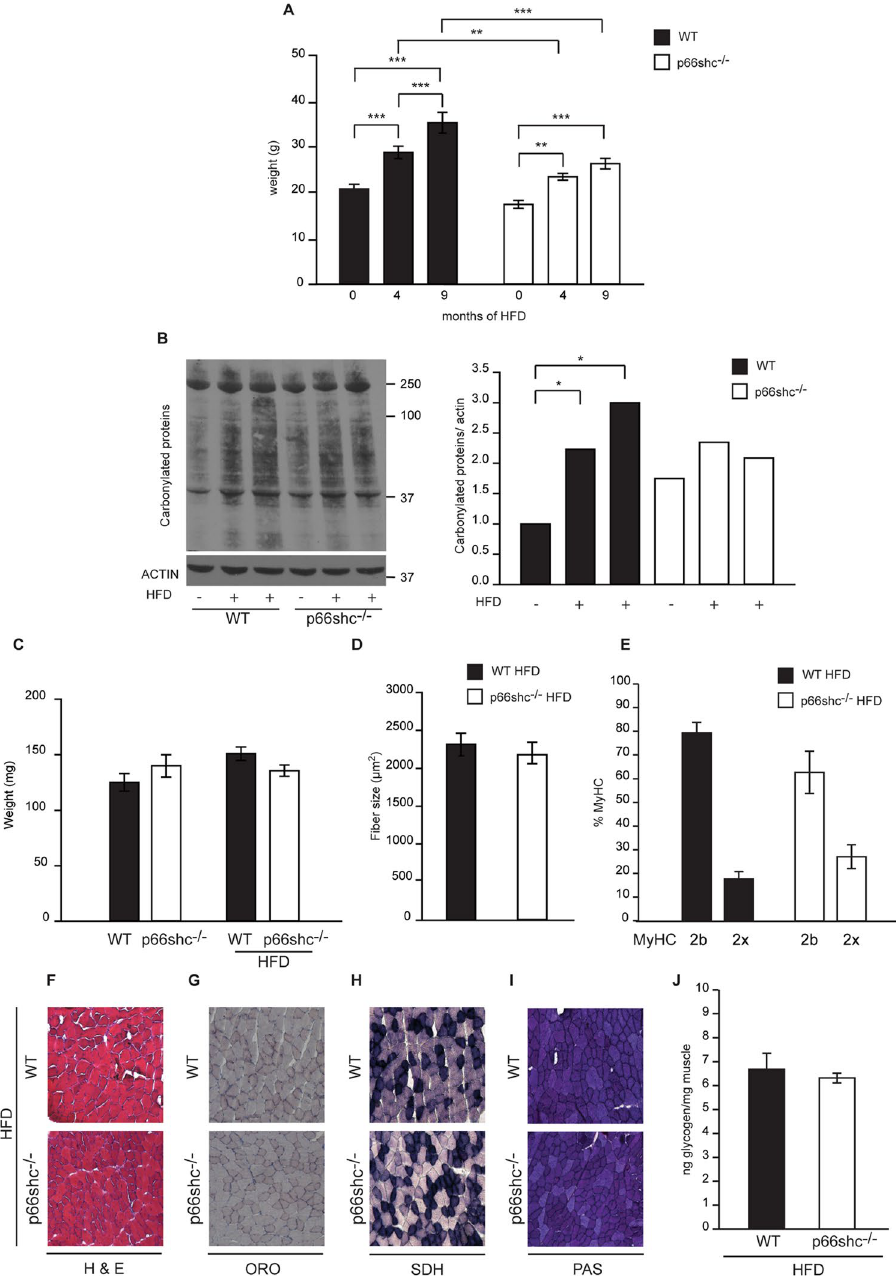
Figure 4. Trophic and metabolic properties of p66shc − / − muscles upon HFD. ( A ) Female wt and p66shc − / − mice were fed with HFD for 4 and 9 months and body weights were plotted. ** p < 0.01, *** p < 0.005, pairwise multiple comparison (Holm-Sidak method) of 7 animals per condition. Data are presented as mean ± SEM. ( B ) Western blot analysis of carbonylated proteins of wt and p66shc − / − muscles mice after HFD (9 mo) and quantification by densitometry. * p < 0.05 pairwise multiple comparison (Holm-Sidak method). Cropped blots are displayed, and full-length blots are presented in Supplementary Figure S1. ( C ) Gastrocnemius muscle weights of wt and p66shc − / − mice in chow and in HFD conditions. Data are presented as mean ± SEM (5 animals per group). ( D ) Mean fiber size of TA muscles of wt and p66shc − / − mice after HFD (9 mo). Data are presented as mean ± SEM (3 animals per group).( E ) Quantitative myosin distribution analysis of wt and p66shc − / − muscles mice after HFD (9 mo). Data are presented as mean ± SEM (5 animals per group). ( F ) H&E staining of transversal cryosections of TA muscles after HFD (9 mo). ( G – J ) Analysis of the metabolic properties of wt or p66shc − / − muscles after HFD (9 mo). ( G ) Lipid accumulation detected by Oil-red-O (ORO) staining. ( H ) SDH activity assay. ( I ) Glycogen amount detected by Periodic Acid–Schiff (PAS) staining. ( J ) Glycogen amount quantification Data are presented as mean ± SEM (5 animals per